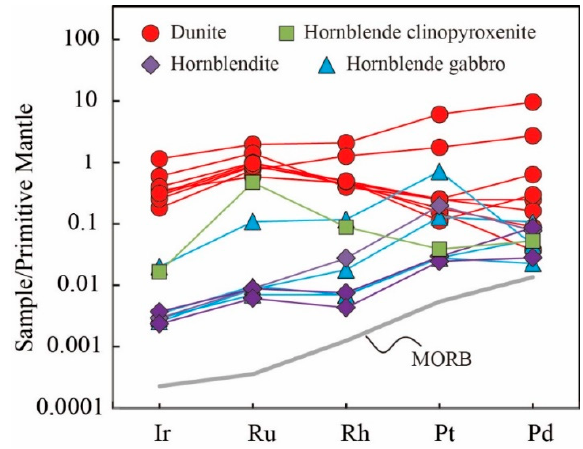
Figure 8. Primitive mantle-normalized PGE patterns for the rocks from the Xiadong Alaskan-type complex. Primitive mantle-normalized values were sourced from Reference [41]. Mid-ocean range basalt (MORB) values were sourced from Reference [43].